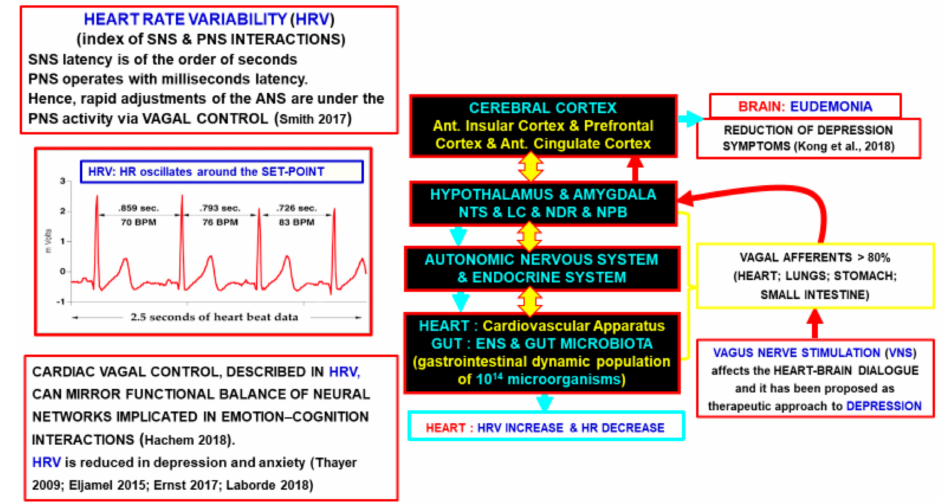
Figure 2. Schematic representation of the crucial role played by the vagal control on the physical and psychic homeostasis of the subject and of the possible diagnostic value of the heart rate variability (HRV). It also indicates the potential therapeutic approach of the vagus nerve stimulation (VNS) for treatment resistant depression.